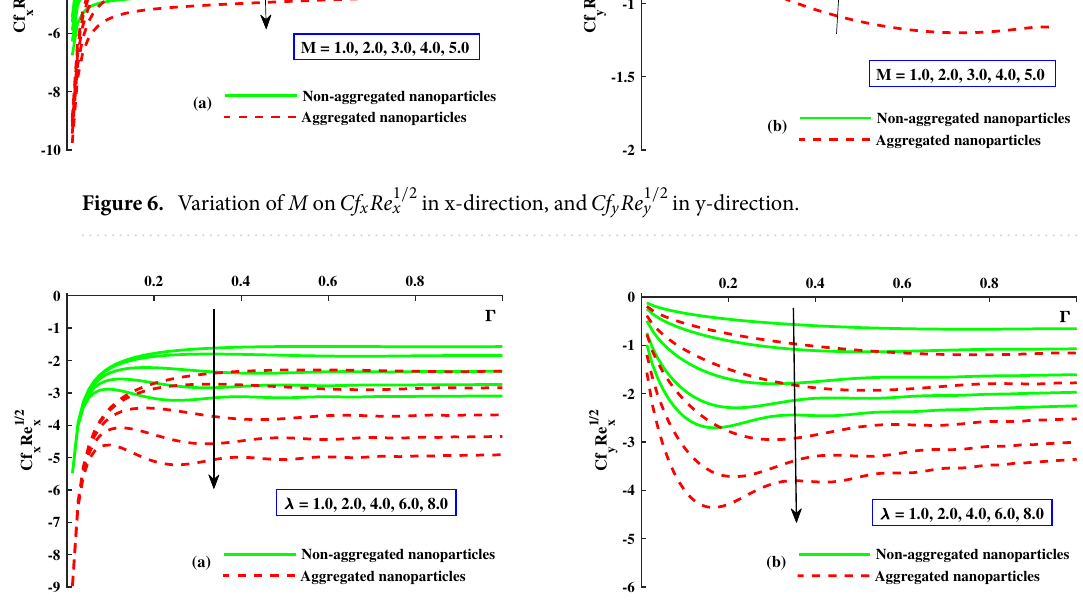
1 / 2 x in x-direction, and Cf y Re